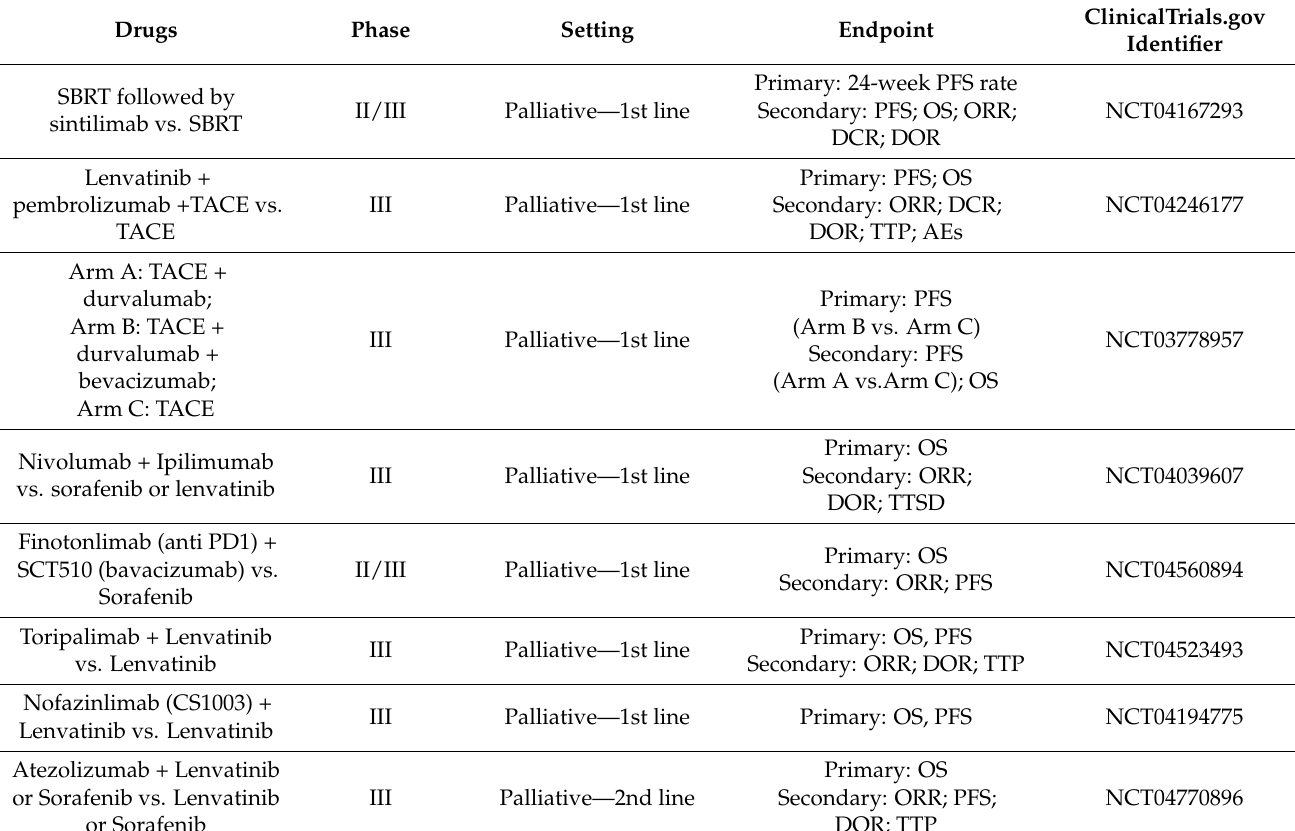
Table 3. Ongoing phase III trials in patients with advanced